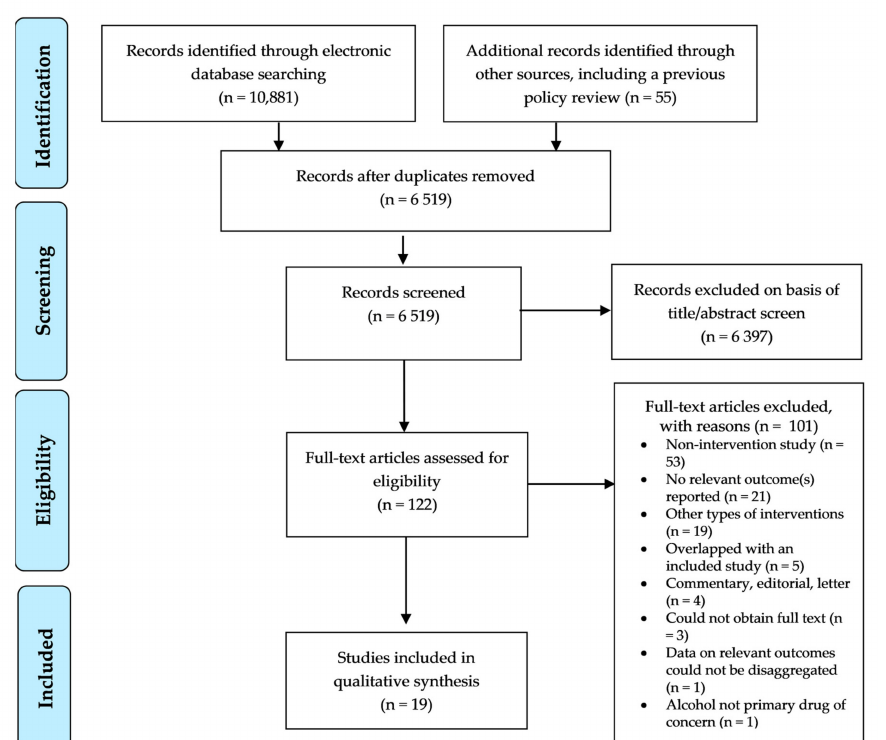
Figure 1. PRISMA